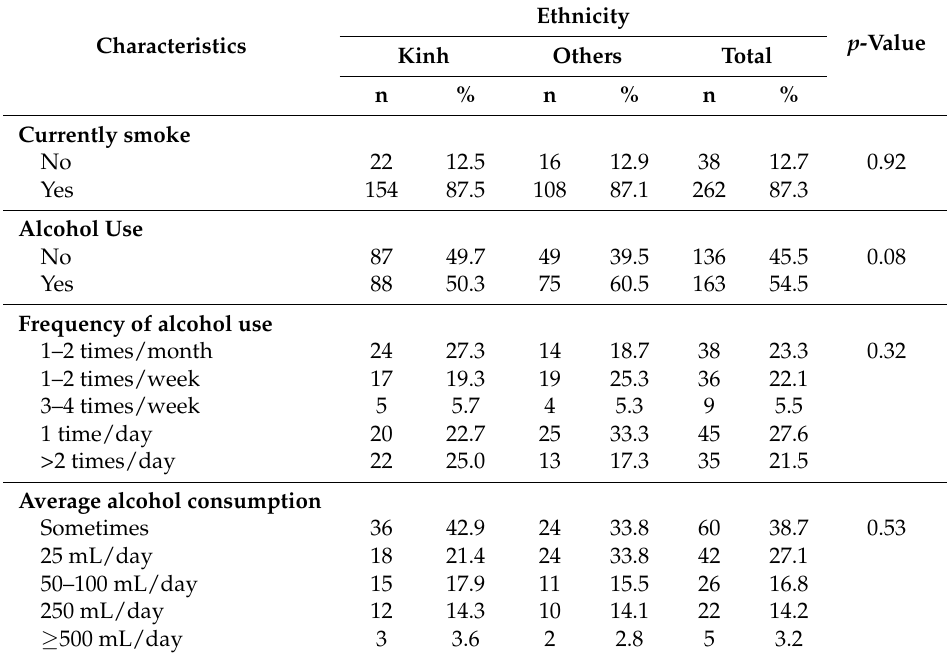
Table 3. A comparison between Kinh and other minority ethnic groups relating to smoking and alcohol